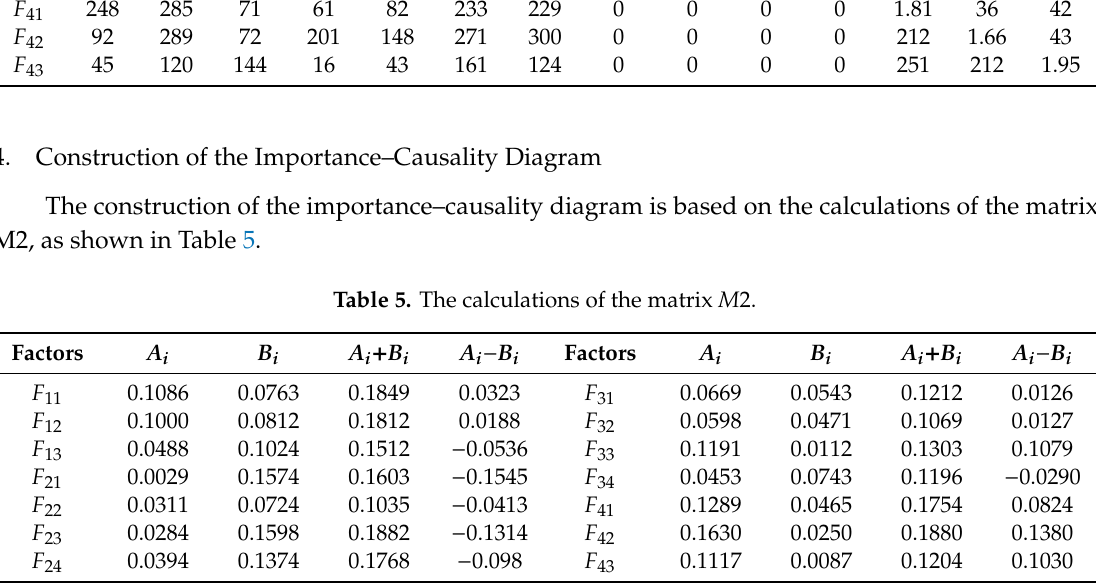
Table 4. The results of the matrix M 2